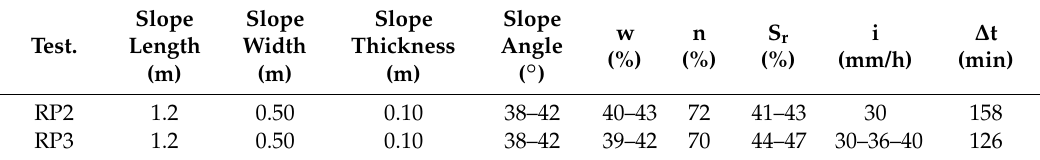
Table 1. Initial soil conditions and slope and rainfall